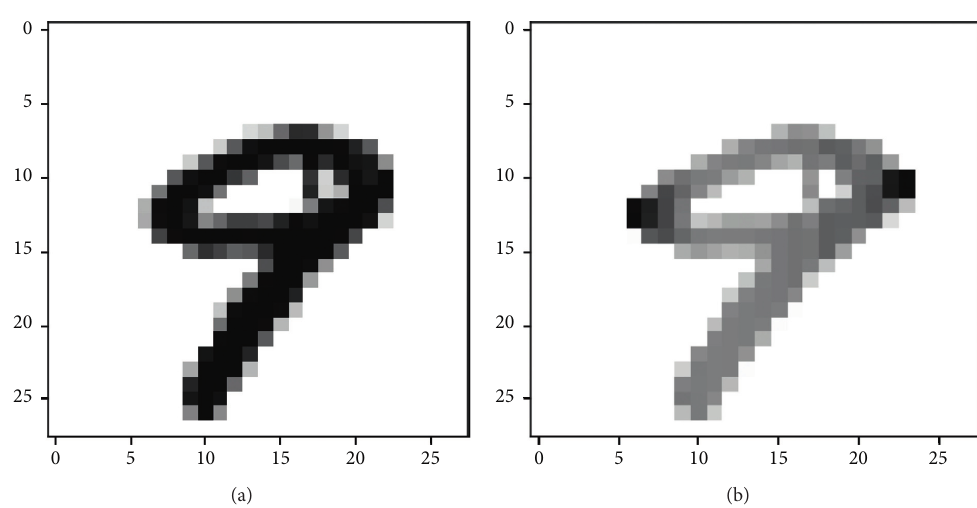
Figure 11: (a) Image from the MNIST dataset. (b) Normalized